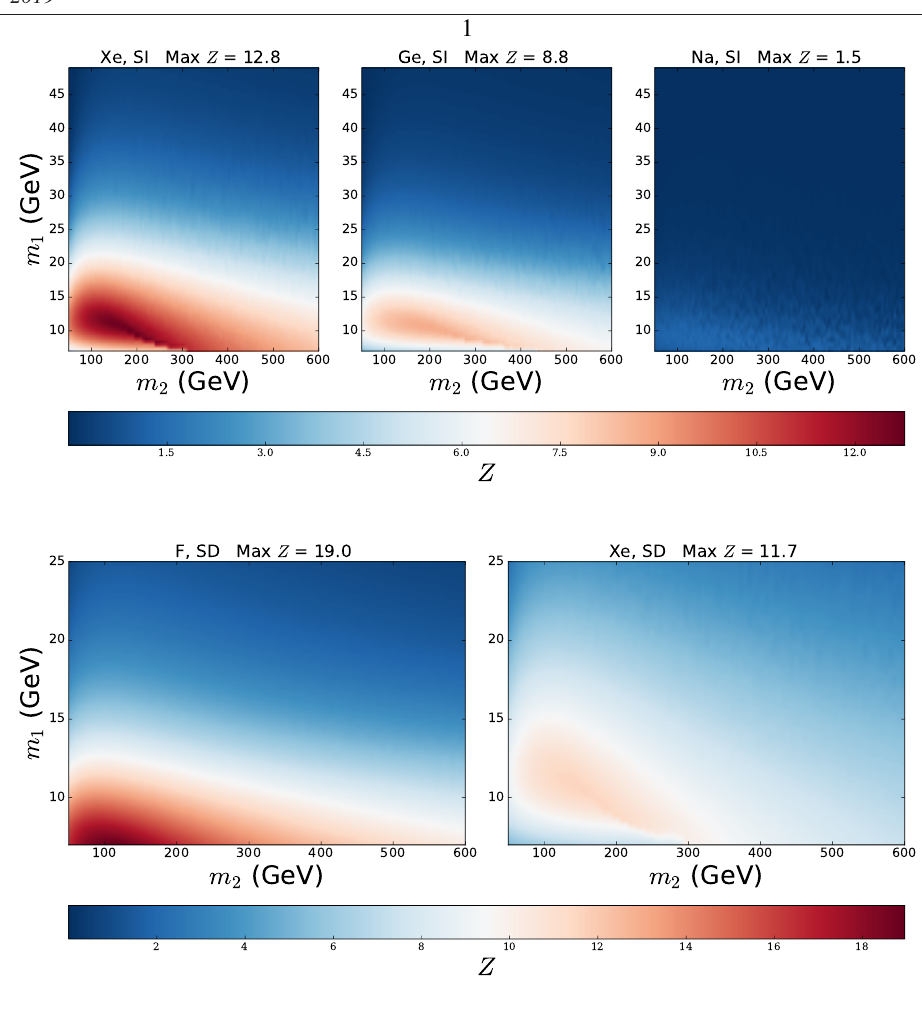
Figure 4. Significance Z with which the median experiment can reject the one-DM hypothesis in favour of the two-DM hypothesis in the m 2 − m 1 plane for di ff erent target nuclei. All other model parameters are fixed when generating the Asimov data: r ρ = r σ = 1, κ 1 , 2 = 1 and σ H the symmetric region around the axis m 1 = m 2 for clarity. The top panel is for SI interactions for Xe, Ge and Na, while the bottom panel is for SD interactions for F and